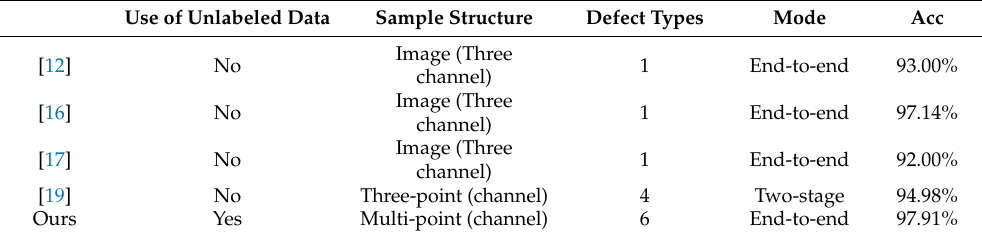
Table 10. Comparison with previous work.